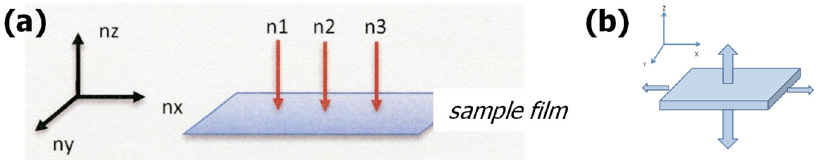
Figure 8. ( a ) The thickness and refractive index measurement at three points of the polyimide. ( b ) An imaginary depiction of the film expansion toward out-of-plane direction. Table 4. The normalized retardation values of the CpODA-based polyimide films.